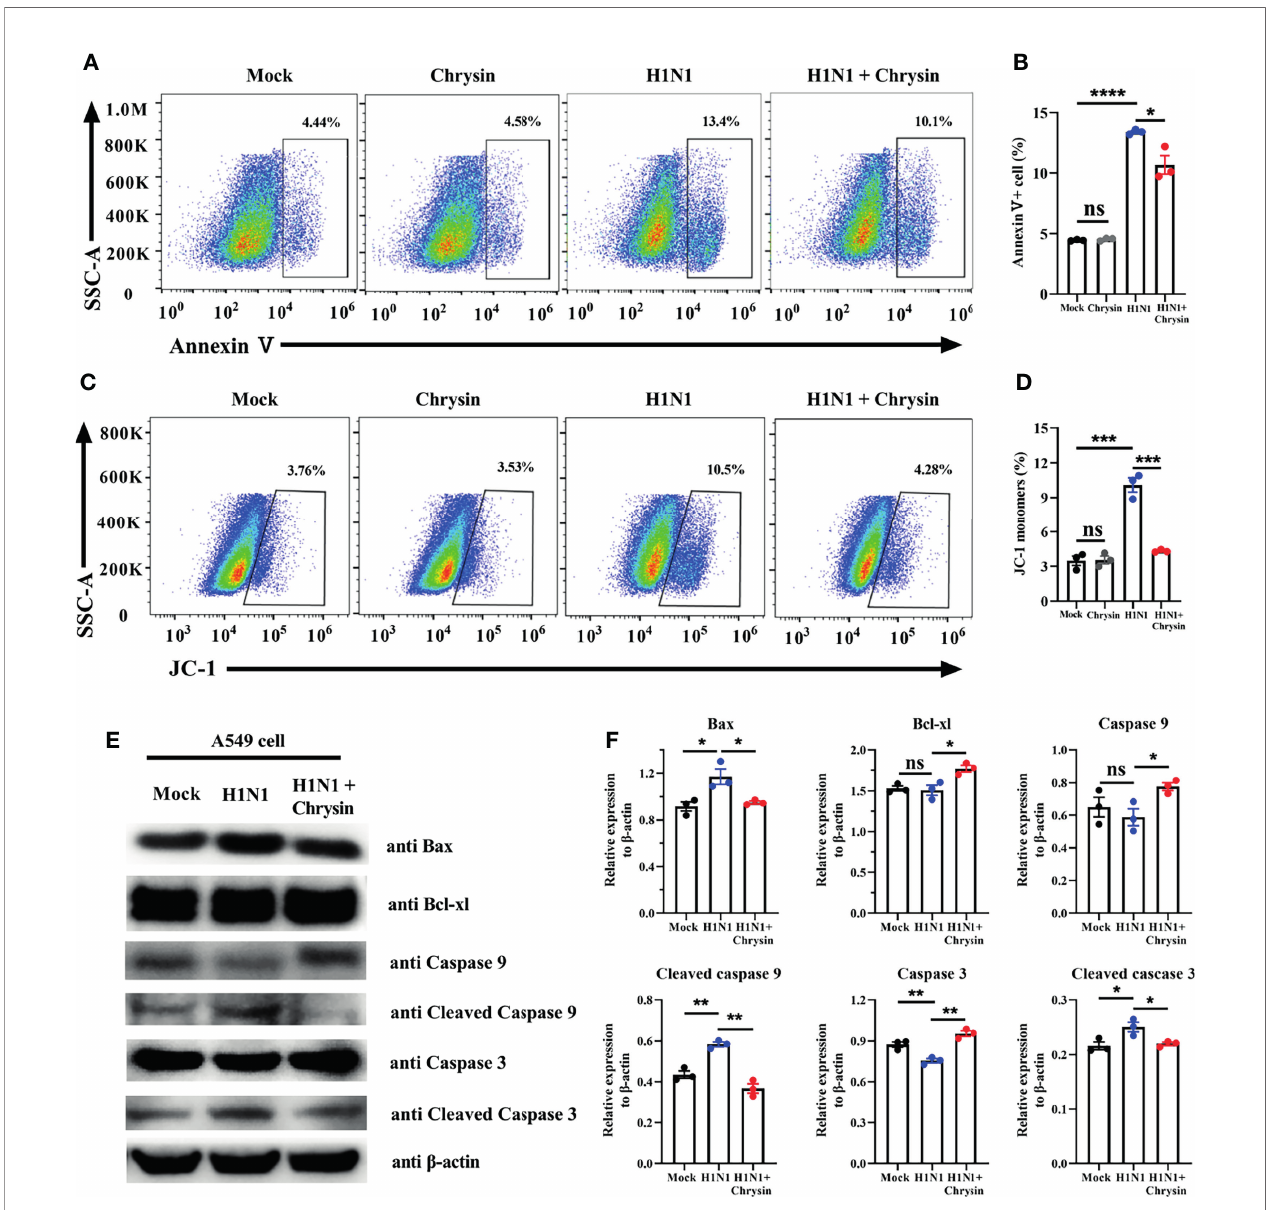
FIGURE 6 | Chrysin inhibits the mitochondrial apoptosis pathway in H1N1 in fl uenza virus-induced epithelial cells. A549 cells were infected with MOI of 0.5 A/PR/8/34 (H1N1) virus and chrysin for 2 hours, then the supernatant was removed and supplemented with fresh medium containing 8 m M chrysin for 10 hours of stimulation. (A) Cells were stained with Annexin V, and then analyzed by fl ow cytometry. (B) Statistical analysis of early Annexin V + apoptosis ratio. (C) Representative histograms of JC-1 staining as measured by fl ow cytometry. (D) Statistical analysis of the monomeric JC-1 cell population. (D) Western blot of Bax, Bcl-xl, caspase 9, cleaved caspase 9, caspase 3, cleaved caspase 3. (E) Statistical analysis of the relative protein expression levels of Bax, Bcl-xl, caspase 9, cleaved caspase 9, caspase 3, cleaved caspase 3, protein loading were normalized based on b -actin and shown as a regular value. Data are representative of three similar experiments and are presented as mean ± SEM. *P < 0.05, **P < 0.01, ***P < 0.001, ****P < 0.0001 by unpaired two-tailed Student ’ s t-test. ns, no signi fi cant